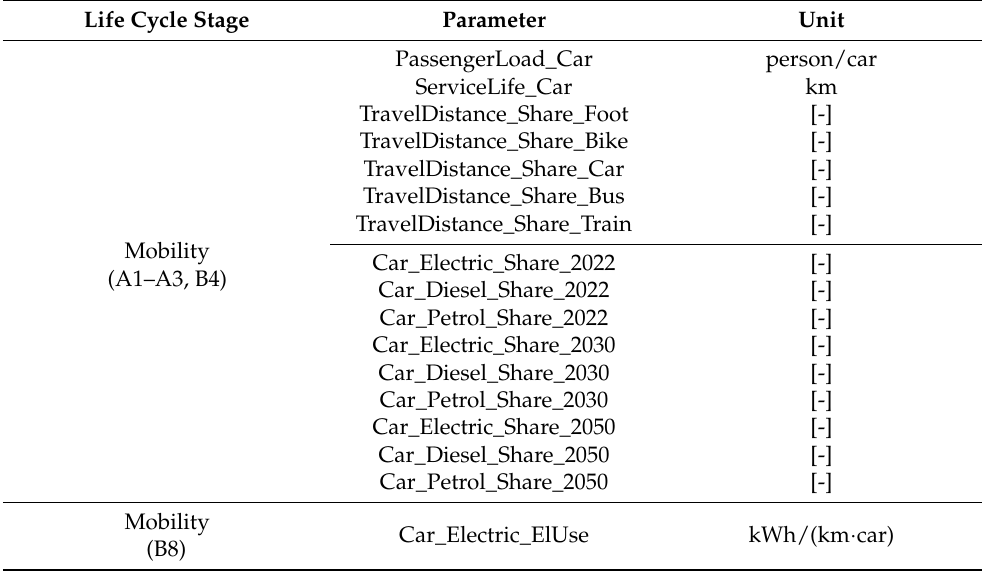
Table A2. List of parameters for the neighborhood sub-element mobility.